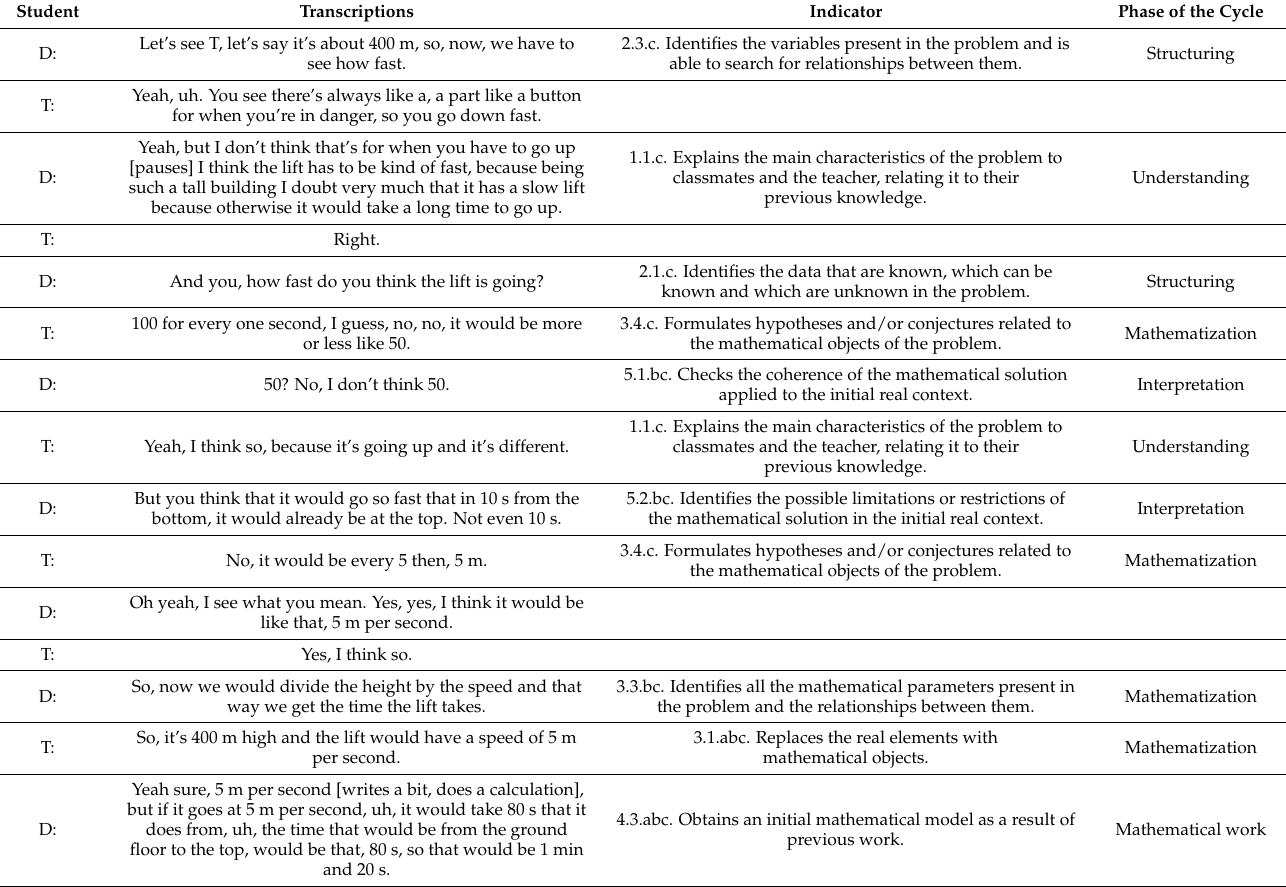
Table 10. Extract from the analysis of the modelling activity in compulsory secondary education with the REPMM instrument. Indicator Phase of the